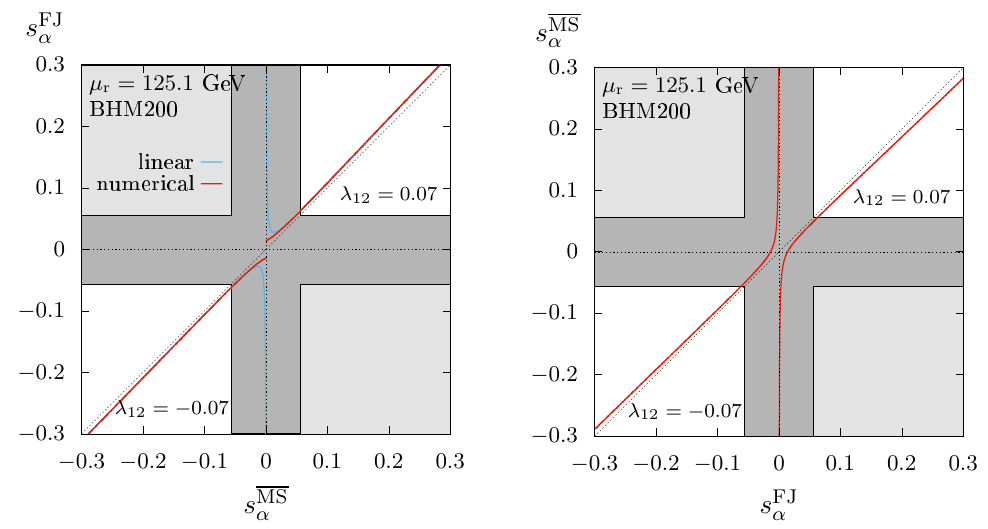
Figure 9 . Conversion of the input parameter s (cid:11) between the MS and the FJ schemes. The heavy Higgs-boson mass M H is (cid:12)xed according to the benchmark scenarios BHM200 (cid:6) . The dark-gray area denotes s (cid:11) values for which (cid:21) 1 becomes non-perturbative. In the light-gray regions the sign of s (cid:11) is (cid:13)ipped by the conversion and becomes inconsistent with the sign of (cid:21) 12